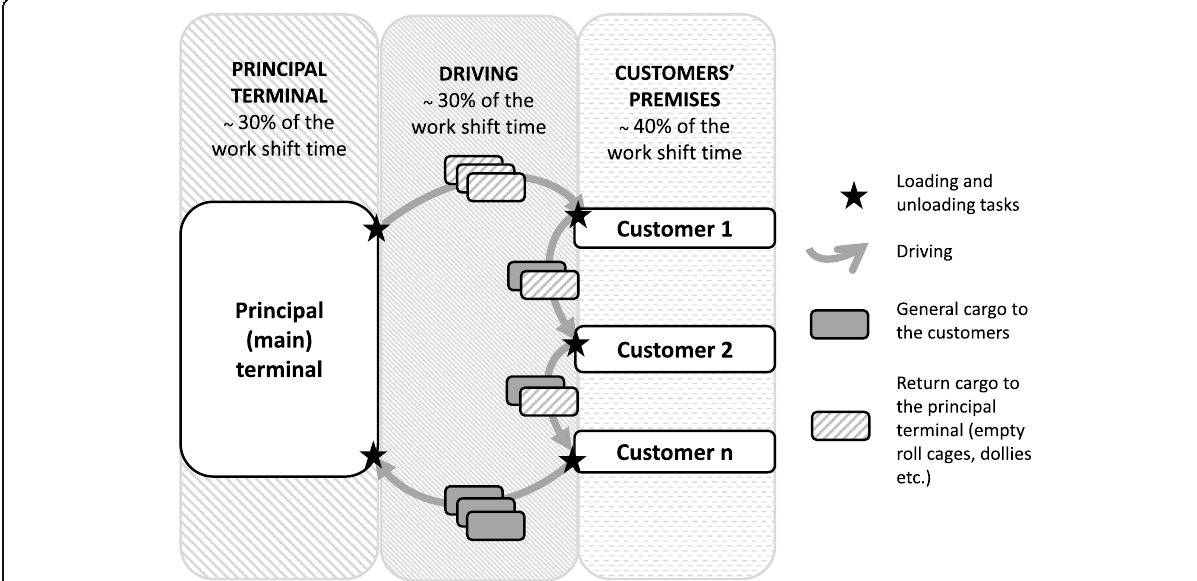
Fig. 1 Simplified illustration of a delivery process based on Pekkala [11]. There are three main work phases in truck drivers ’ routine, daily work: unloading and loading at the principal (main) terminal or warehouse, driving, and unloading and loading at different customers ’